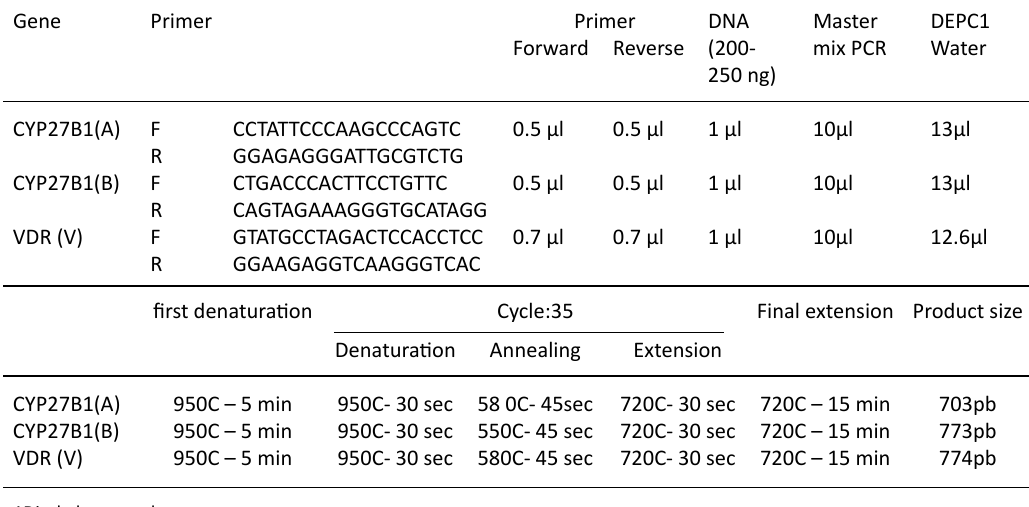
Table 2. PCR reaction protocol